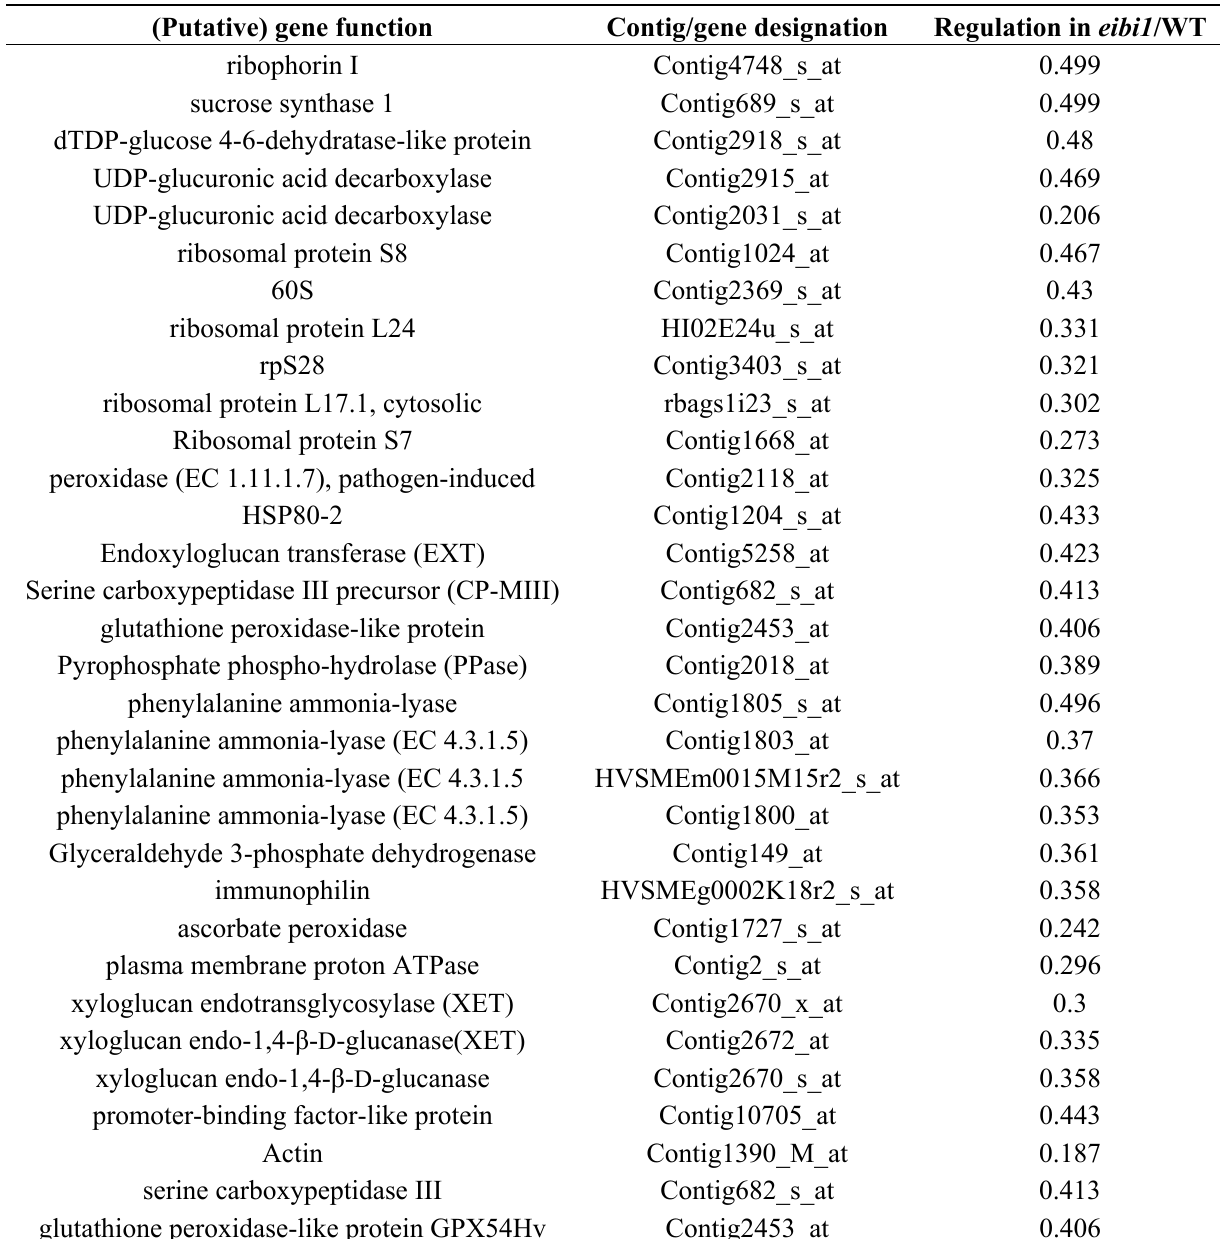
Table 2. Differentially down-regulated genes in eibi1